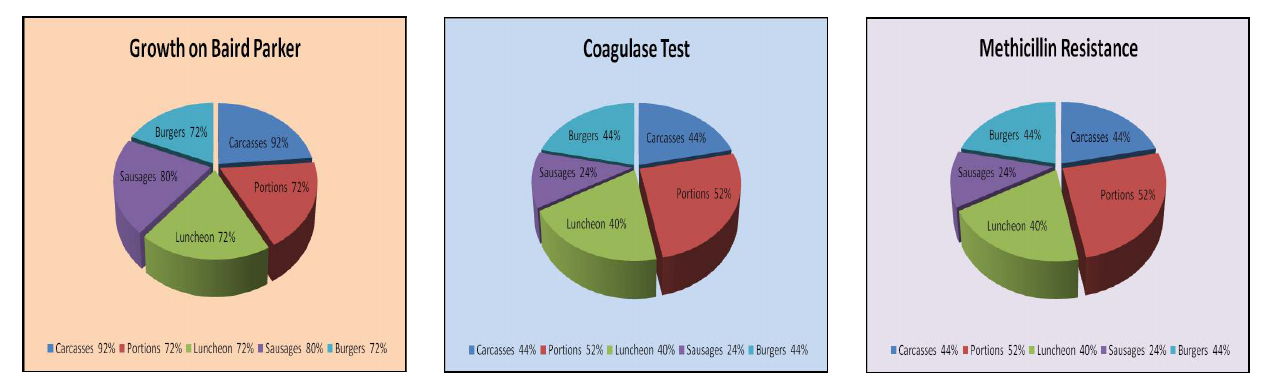
Figure-2. Rate Percentage of positive isolates for coagulase test and methicillin resistance in poultry meat and poultry